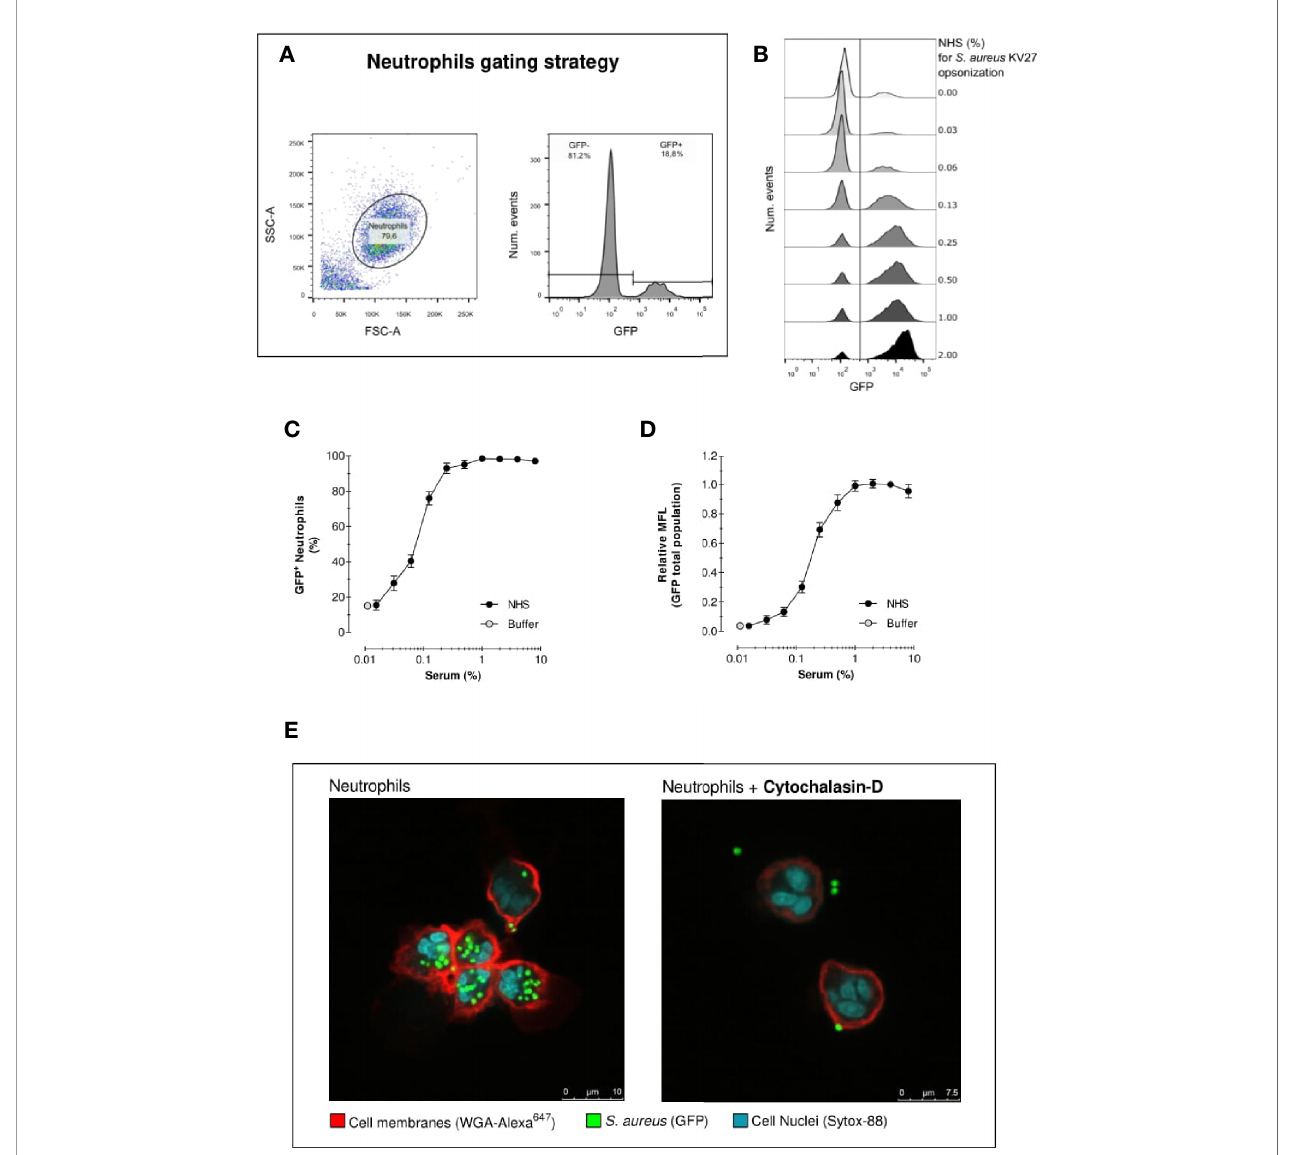
FIGURE 1 | Acquisition of phagocytosis assay by fl ow cytometry. Acquisition of neutrophil phagocytosis of S. aureus KV27 opsonized with normal human serum (NHS) at a 10:1 bacteria-to-cell ratio after 15 min incubation. (A) Gating of PMNs in the linear FSC and SSC, required to eliminate cell debris and possible free or clumped bacteria from the analysis (left graph). Representative histogram describing the GFP intensity per number of events. The total population is composed by a percentage of GFP- and GFP+ PMNs (right graph). (B) Typical histogram overlay of the GFP intensity distribution of the total neutrophil population per each concentration point of opsonizing NHS. (C) Phagocytosis expressed as the % of GFP+ neutrophils per increasing % of NHS. Mean ± SEM for n=8 – 25 (D) Phagocytosis expressed as the Mean Fluorescence (MFL) of neutrophils relative to the MFL obtained with opsonization with 4% NHS. Mean ± SD for n=8 – 25. (E) Confocal image of S. aureus KV27 (green, GFP) incubated with 4% NHS engulfed by human neutrophils (red, membrane stain WGA-Alexa647 and blue, nuclear stain SYTO-82), control (right image) or treated with actin-blocking agent cytochalasin-D (left